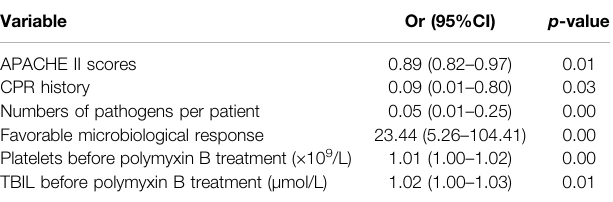
TABLE 4 | Multivariate analysis of a favorable clinical outcome. TABLE 5 | Multivariate analysis of early